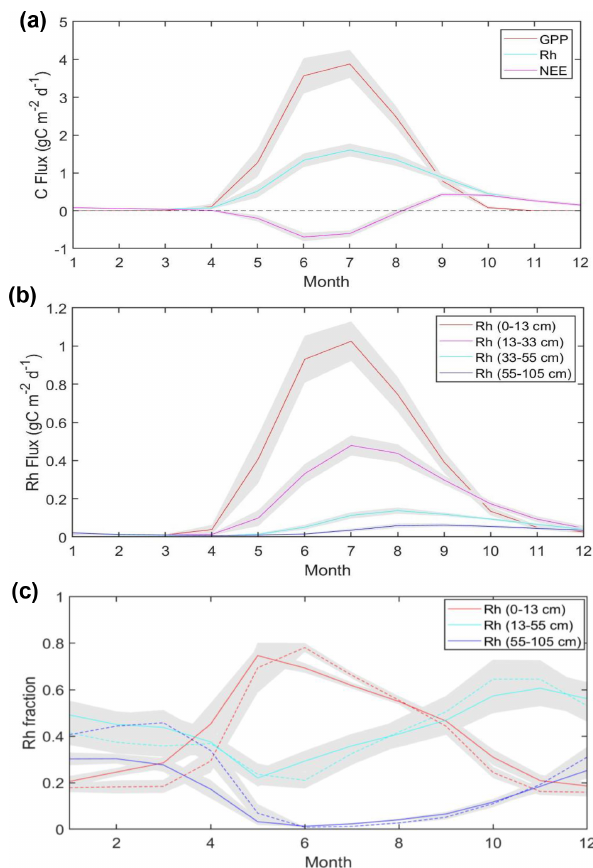
Figure 7. Regional mean of model-simulated carbon fluxes (a), Rh fluxes from different soil depths (b) averaged across Alaska, and Rh contribution from different soil depths to total Rh averaged across two regions with different permafrost probability (c) . In (c) , solid and dashed lines represent the mean values averaged across areas with permafrost probability from 0% to 33% and 67% to 100%, respectively. Gray shading denotes the standard deviation of monthly mean fluxes from 2001 to